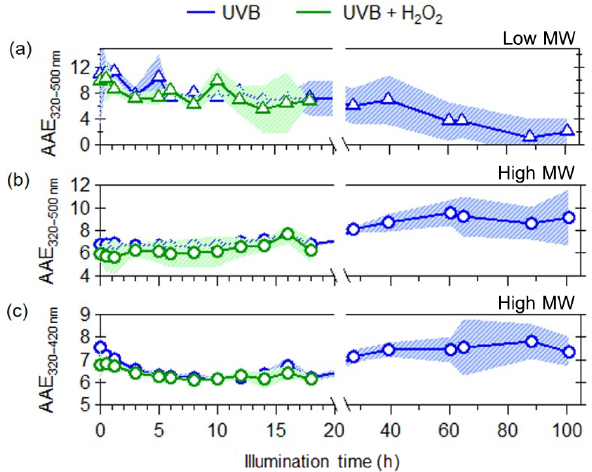
Figure 4. Evolution of AAE due to UVB photolysis (blue) and aqueous OH oxidation (green) for (a) low-molecular-weight BrC (triangles), (b) high-molecular-weight BrC (circles) from 320– 500nm, and (c) high-molecular-weight BrC from 320–420nm. The shaded areas represent the variability ( ± 1 σ ) in multiple experi- ments ( n =